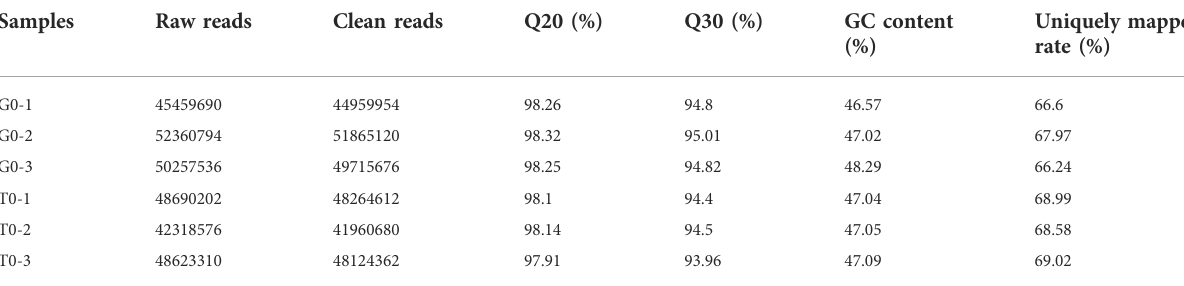
TABLE 3 Sequencing data quality and sequence alignment for all samples. Samples